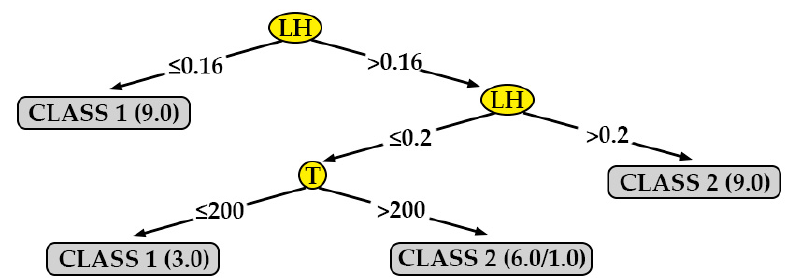
Figure 9. Decision tree for surface roughness measured in the direction parallel to the extrusion path on printed specimens in the XZ orientation (R a,0,XZ ).